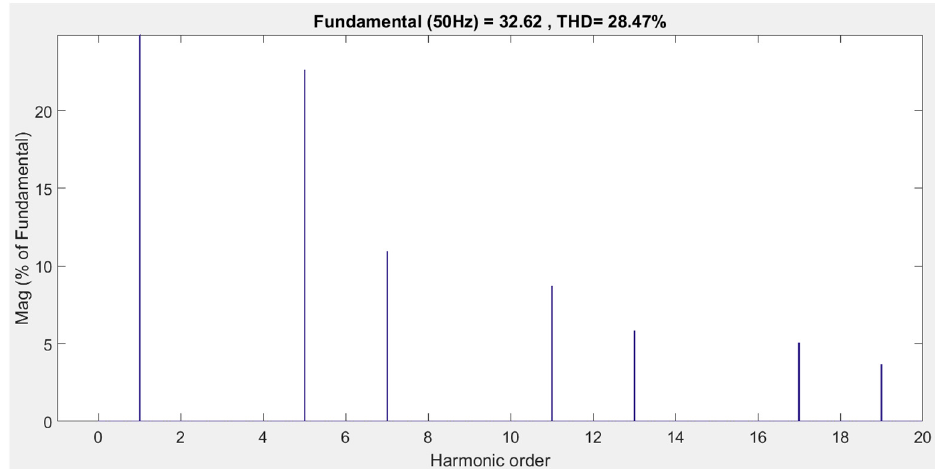
Figure 15. Harmonic diagram of load current without PV inverter.